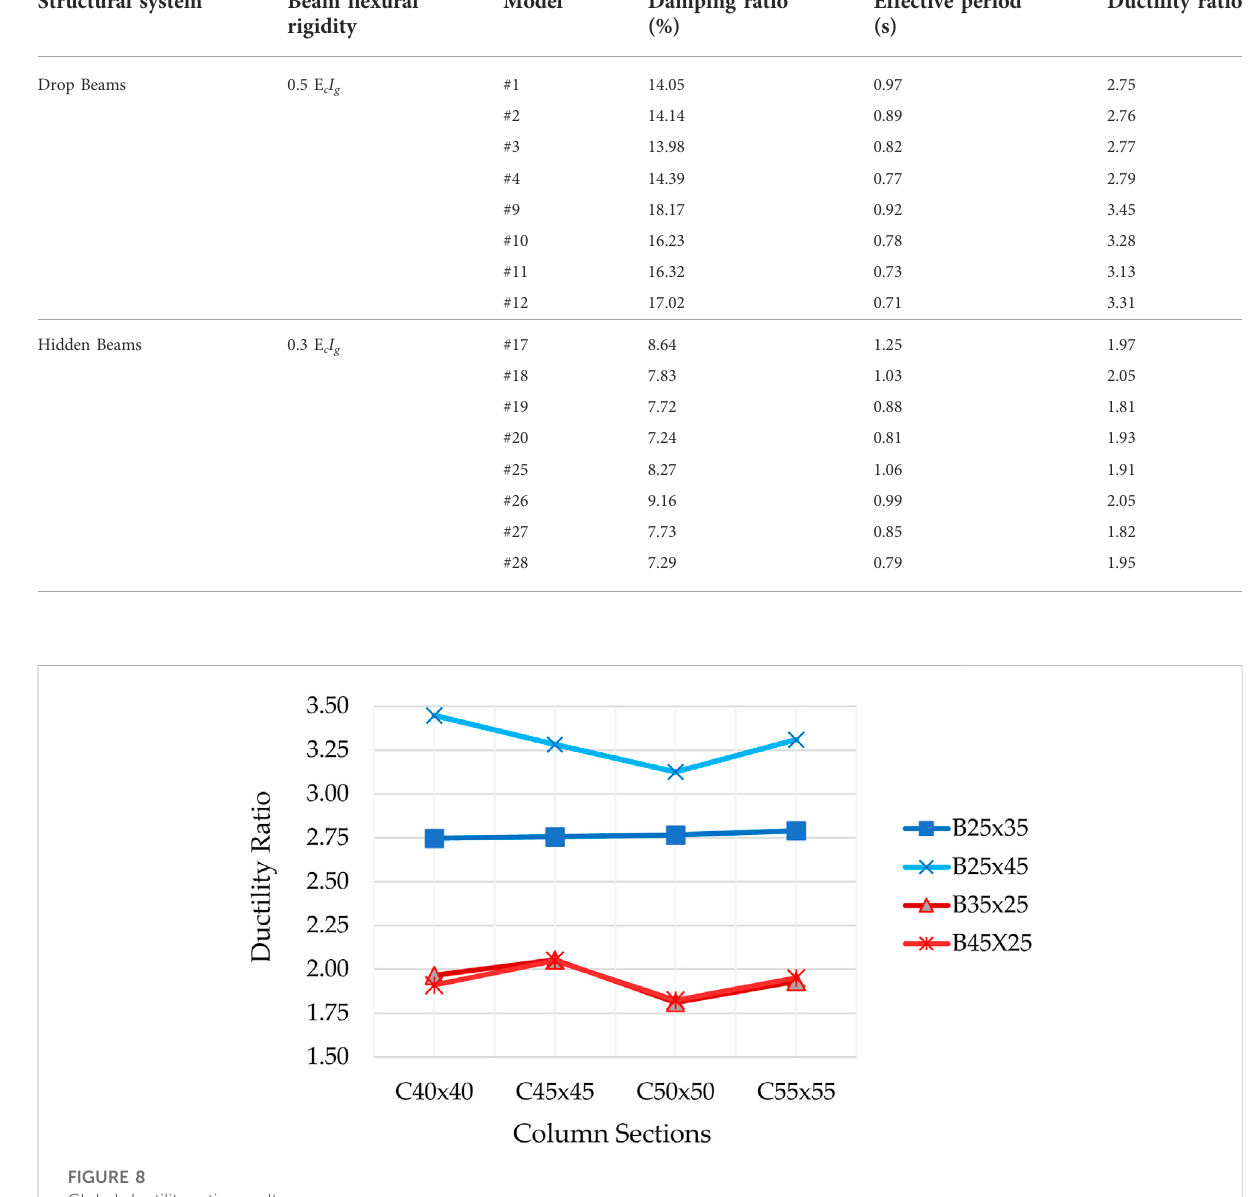
Table 7 summarizes the longitudinal reinforcements of columns.